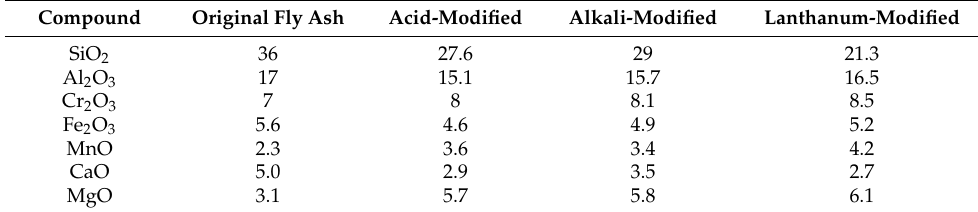
Table 4. Analysis of elemental composition of four types of fly ash